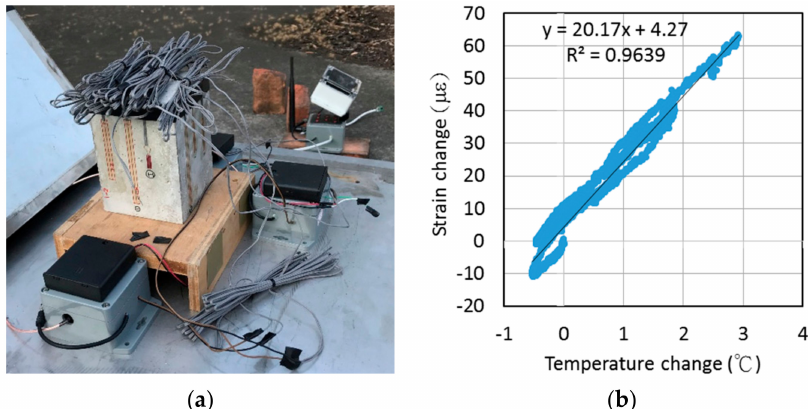
Figure 3. The combined temperature e ff ect coe ffi cient γ value test of a strain gauge (PFL-20mm) attached to the concrete beam: ( a ) specimen photograph; ( b ) test results ◦ .